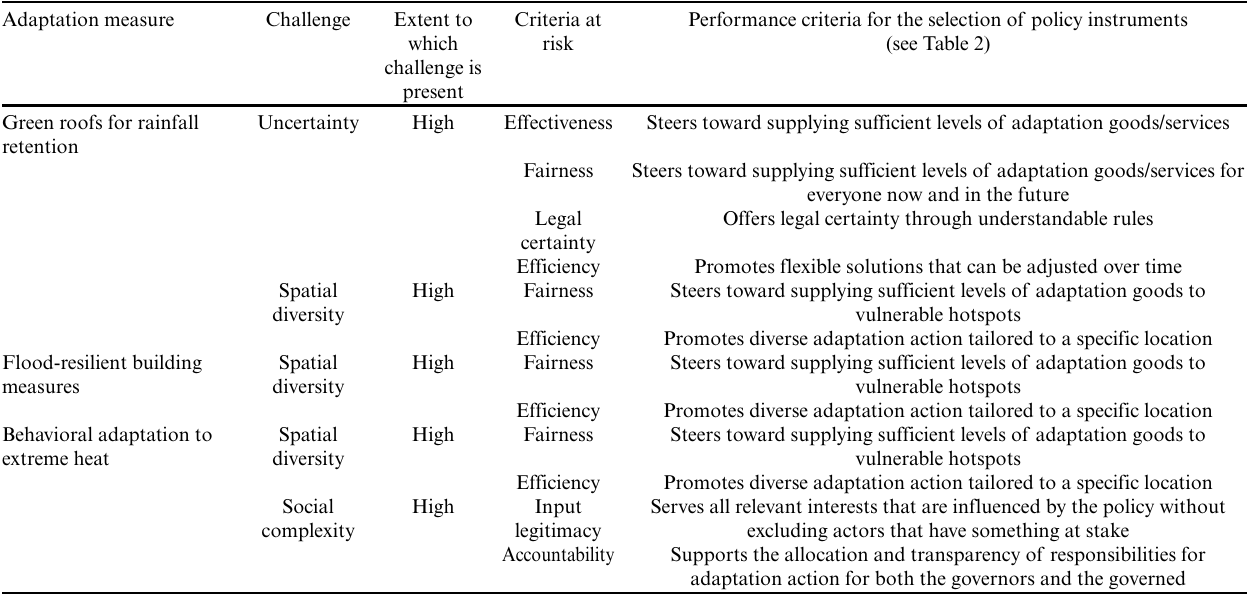
Table 5. Measure-specific relevant criteria for the selection of policy